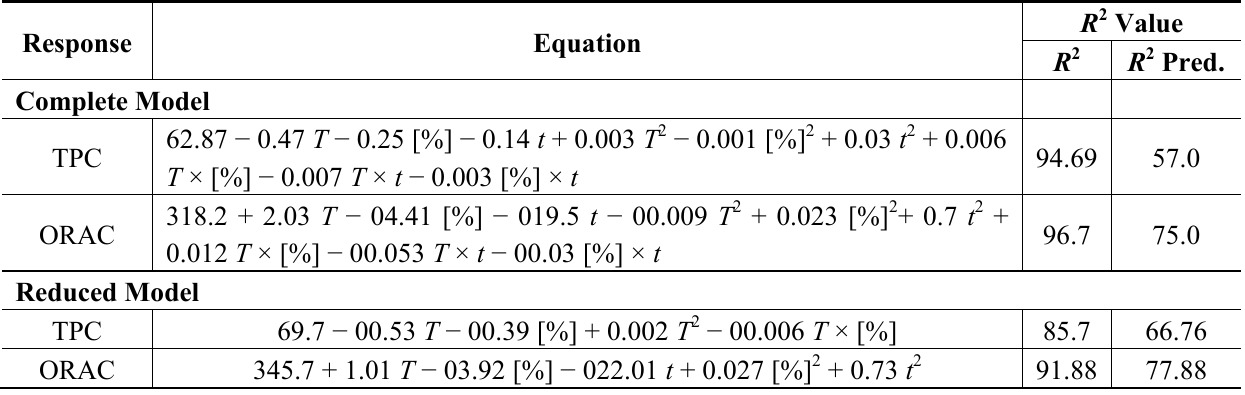
Table 3. Mathematical equations from Response Surface Method (RSM) for each of the responses, with their respective value of R 2 and R 2 -predicted.